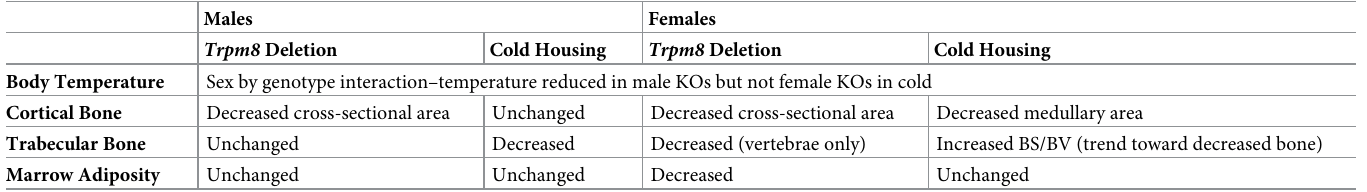
Table 3. Summary of